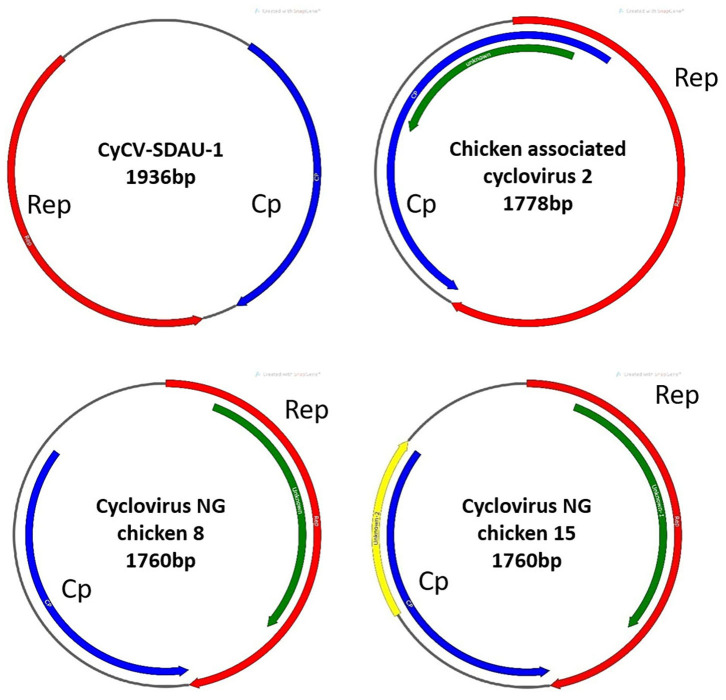
Phylogenetic analysis of whole-genome sequences of the CyCV-SDAU-1 based on nucleotide sequences. The phylogenetic tree showed that CyCV-SDAU-1 may be the origin of other cycloviruses or some circoviruses. The phylogenetic analysis was performed using MEGA 6.0 using the neighbor-joining method with 1,000 bootstrap replicates. Scale bars are proportional to the genetic distance. Bootstrap values > 70% are shown at each node. Red and bold indicate the CyCV-SDAU-1 strains.